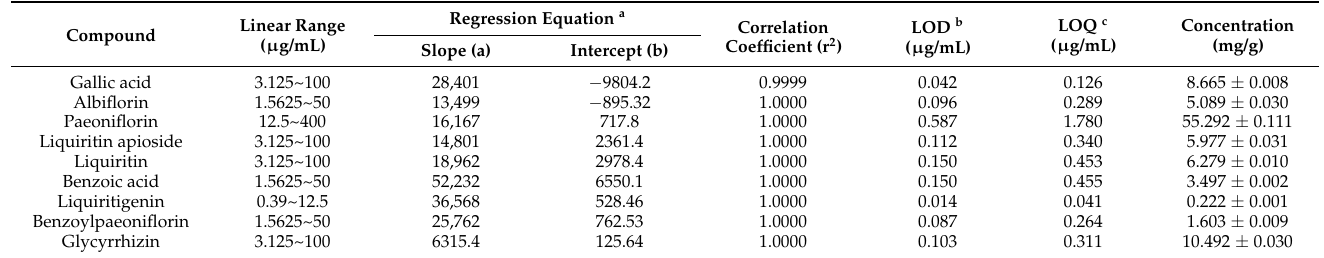
Figure 2. Simultaneous quantification of nine compounds in JGT. ( A ) HPLC chromatograms of the water extract of JGT at 230, 250, and 275 nm. ( B ) Chemical structures of the nine compounds. 1, gallic acid; 2, albiflorin; 3, paeoniflorin; 4, liquiritin apioside; 5, liquiritin; 6, benzoic acid; 7, liquiritigenin; 8, benzoylpaeoniflorin; 9, glycyrrhizin. Table 2. Regression parameters, LOD, LOQ, and concentrations of the nine compounds in JGT.